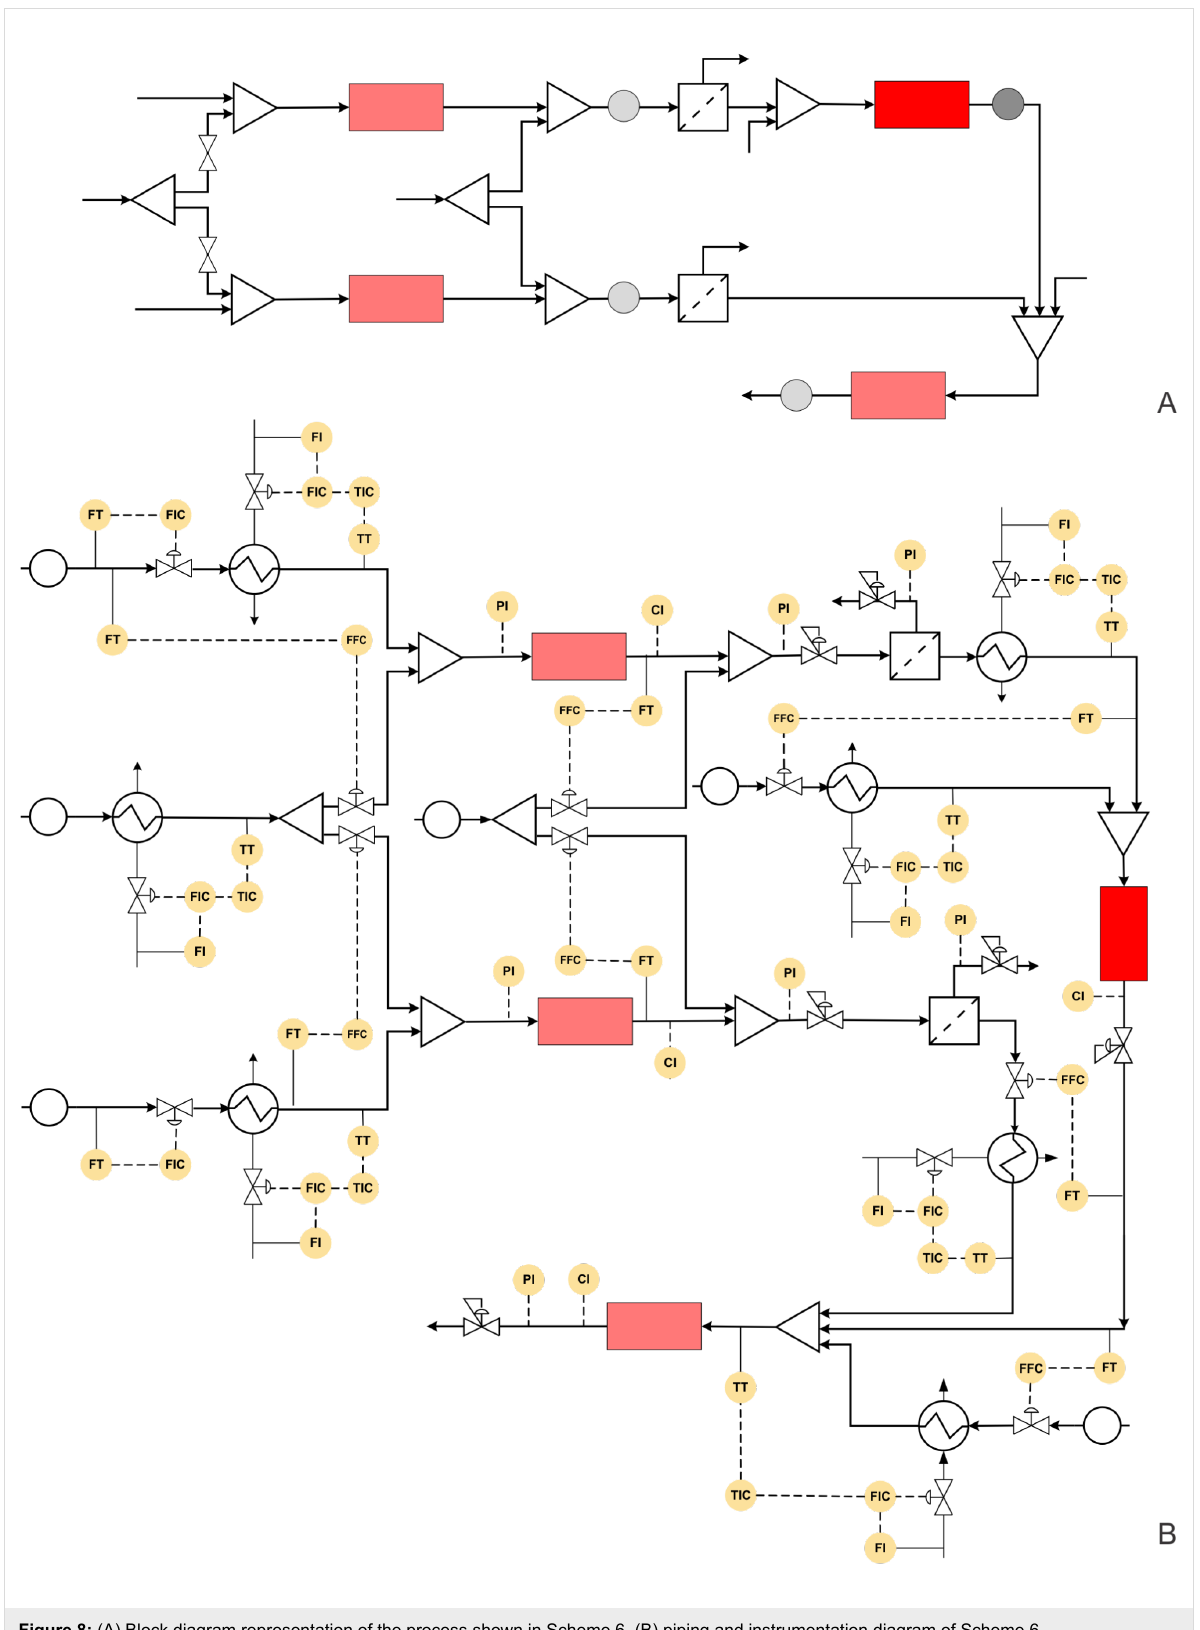
Figure 8: (A) Block diagram representation of the process shown in Scheme 6, (B) piping and instrumentation diagram of Scheme